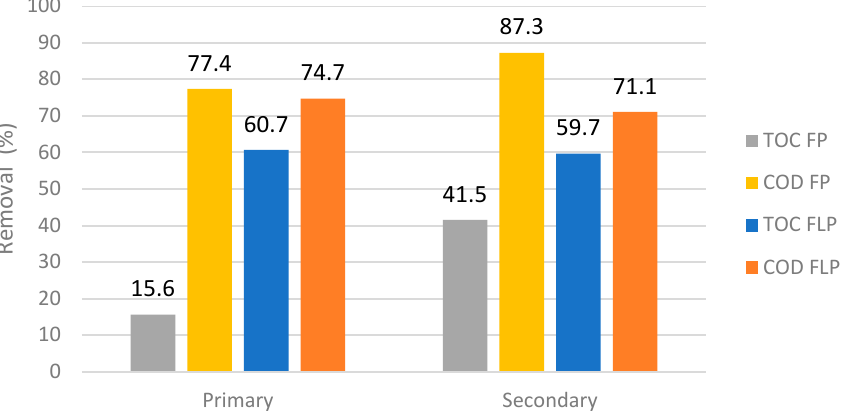
Figure 3. Evaluation of the disinfection in CFU/mL with the optimized conditions on both systems FLP and FP (UDL: under detection limit).